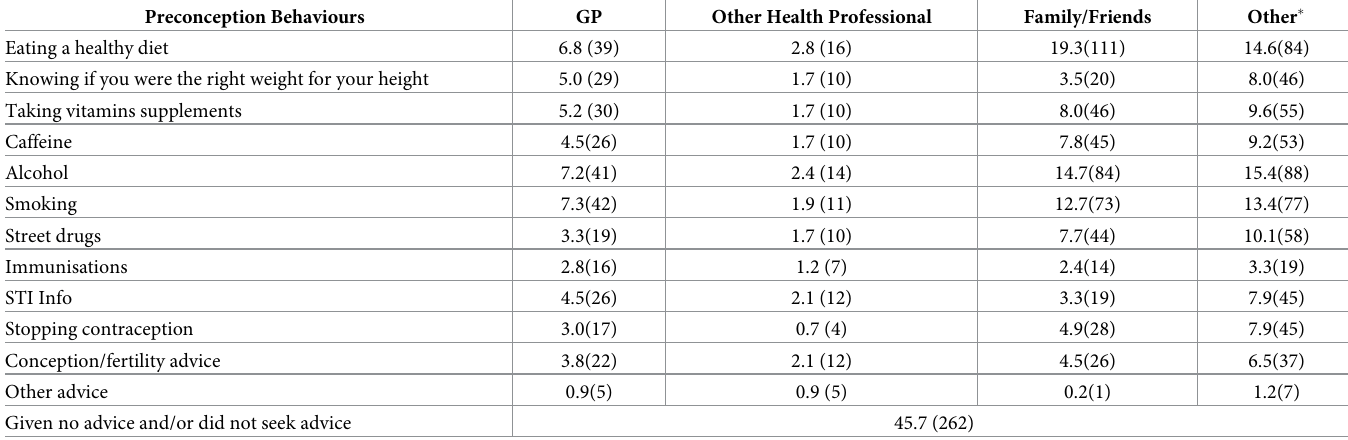
Table 2. Information about preconception health behaviours given to the men before pregnancy by source. (Nb. participants were able to tick multiple sources). Preconception